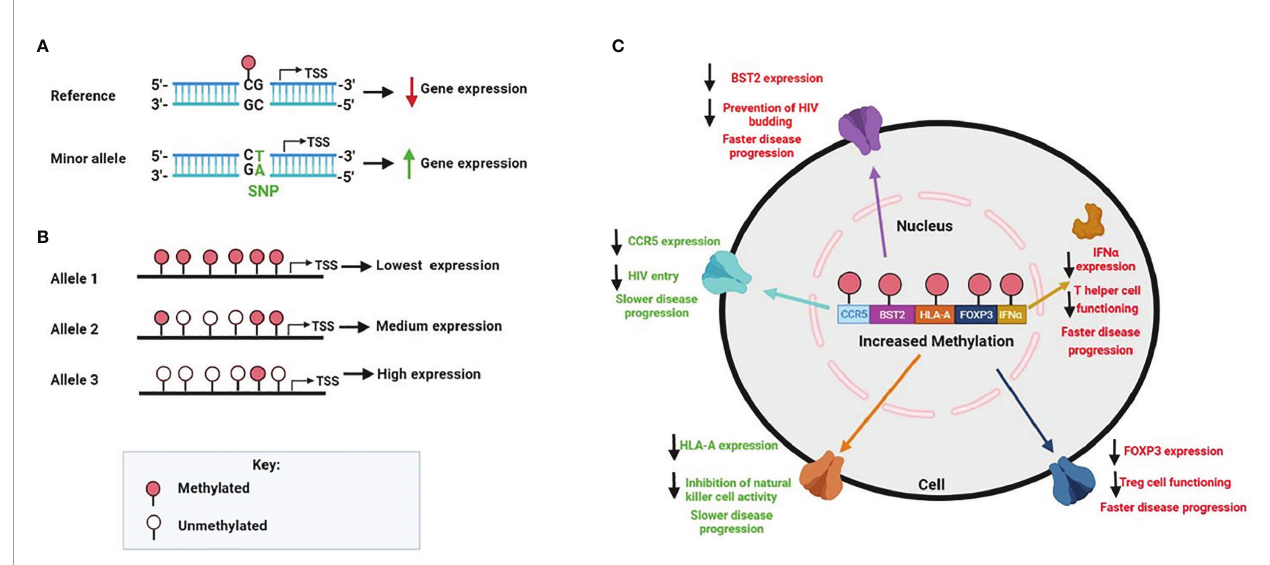
FIGURE 2 | Factors that contribute to human genomic methylation on HIV disease. (A) SNPs found in regulatory gene regions can create or abolish CPG sites, which in turn may affect methylation and gene expression. In the genomic sequence, if C is followed by a G, the C can be methylated; however, when the SNP is mutated from a G to a T, it removes the CpG site and methylation cannot occur (B) DNA methylation can also differ among alleles of a given gene. The number of methylated CpG sites on each allele can affect expression accordingly (C) Increased promoter methylation generally results in decreased mRNA gene expression, which is speci fi cally observed within the HIV setting for the following genes CCR5, BST2, HLA-A, FOX3P and IFN a . Since expression variability of these genes are directly linked to HIV pathogenesis, a change in methylation levels have shown to alter HIV disease progression. Higher levels of methylation for CCR5 and HLA -A results in slower HIV disease progression, however, higher levels of methylation for BST2, FOX3P and IFN a results in faster disease